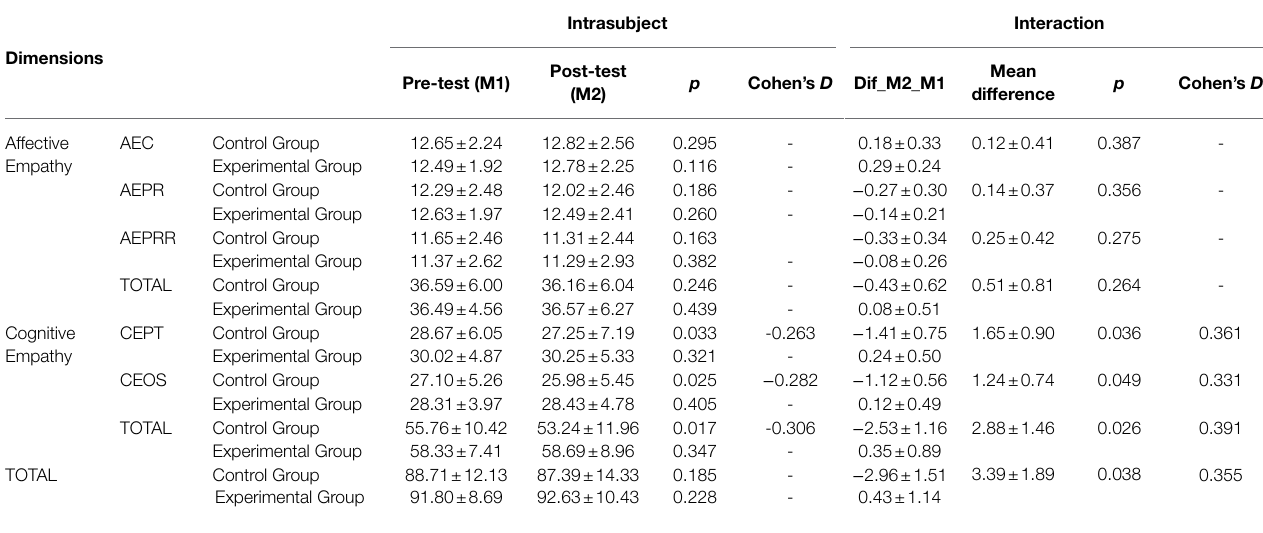
TABLE 2 | Comparative analysis of the means for the pre- and post-test Questionnaire of Cognitive and Affective Empathy (QCAE) in the control and experimental groups (AEC: Affective Empathy-Emotion Contagion; AEPR: Affective Empathy-Proximal responsivity; AEPRR: Affective Empathy-Peripheral Responsivity; CEPT: Cognitive Empathy-Perspective Taking; and CEOS: Cognitive Empathy-Online